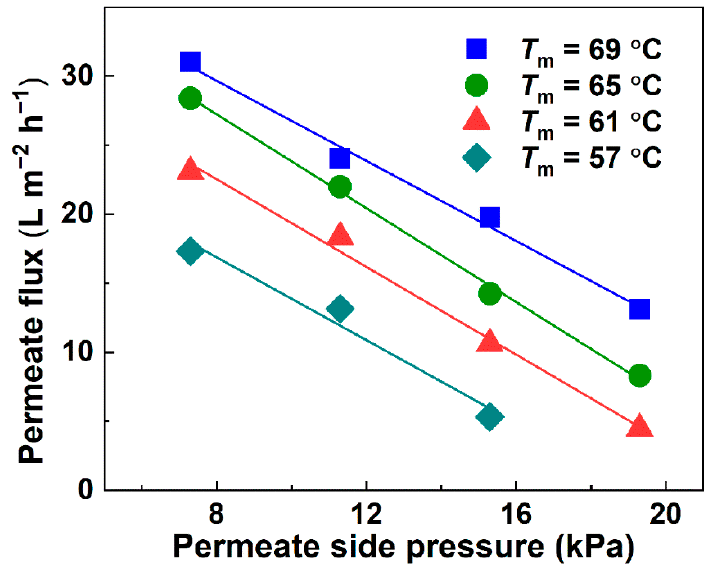
Figure 2. Permeate flux of ersatz urine VMD at various temperatures and permeate side pressures.